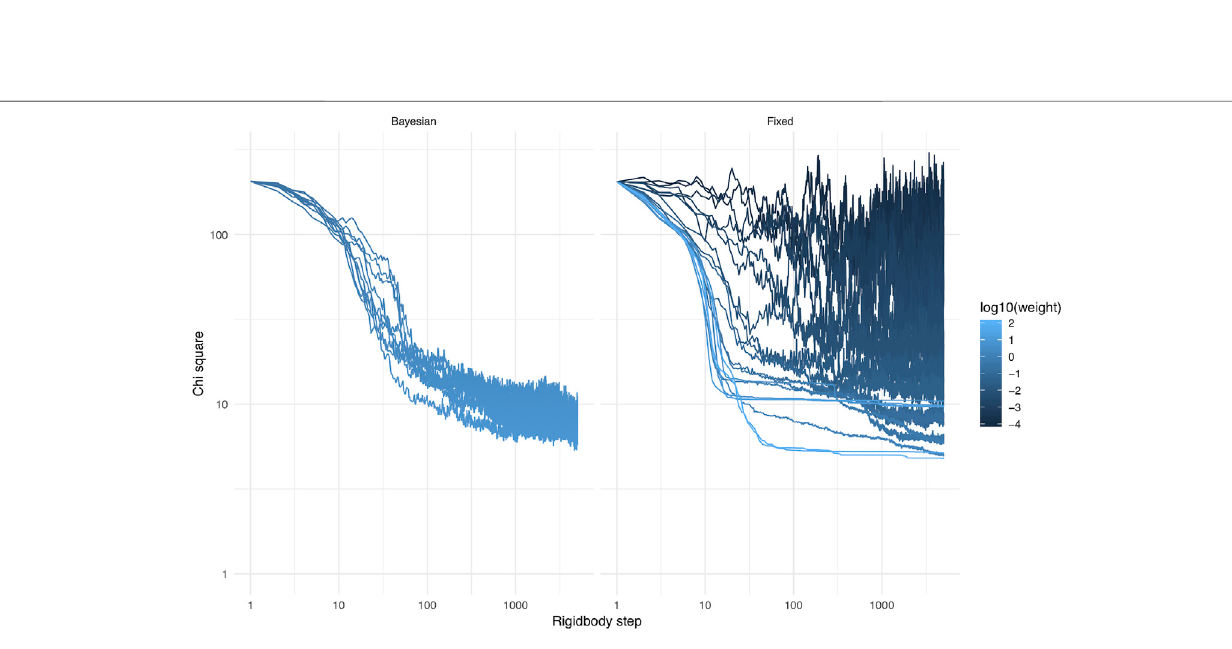
FIGURE 6 | χ 2 score as a function of simulation step, for the 64 rigid body simulations with Bayesian SAXS score (left), and for 20 simulations with a fi xed weight (different in each simulation) and the same, random, starting structure (right).